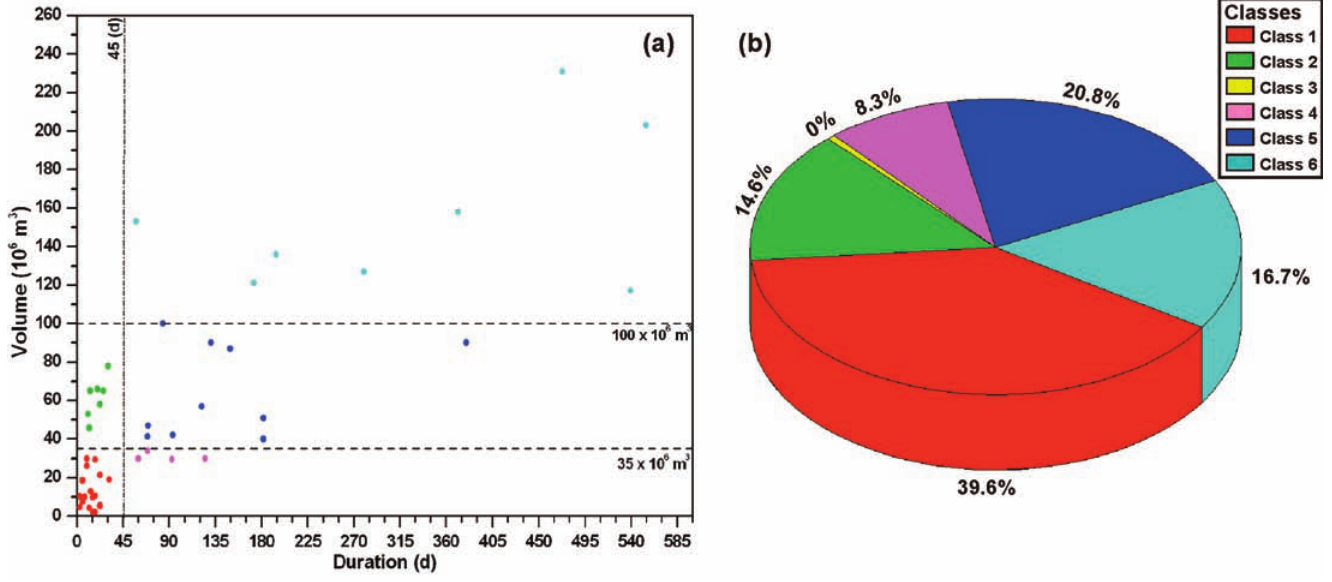
Figure 5. a) Distribution of durations (D) and volumes (V) of the 48 lava flows, and their subdivision into six classes (Class 1: D <45 days, V <35 × 10